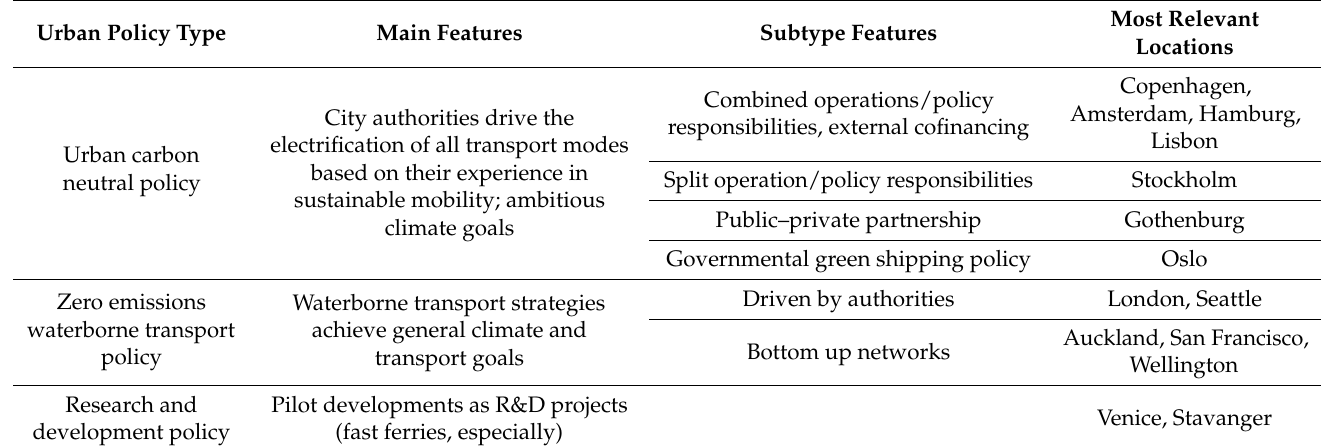
Table 2. Types of local policy involving urban water transit